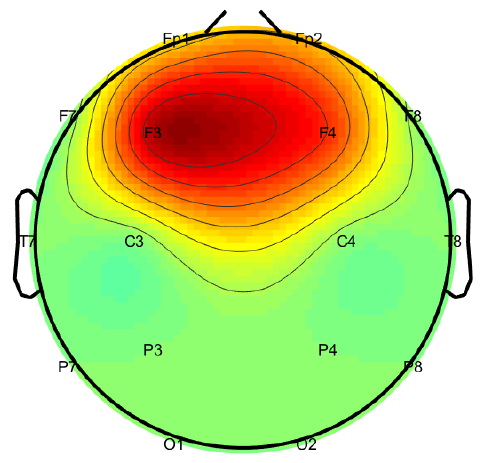
Figure 8. The optimal prediction weights in a 10–20 system .